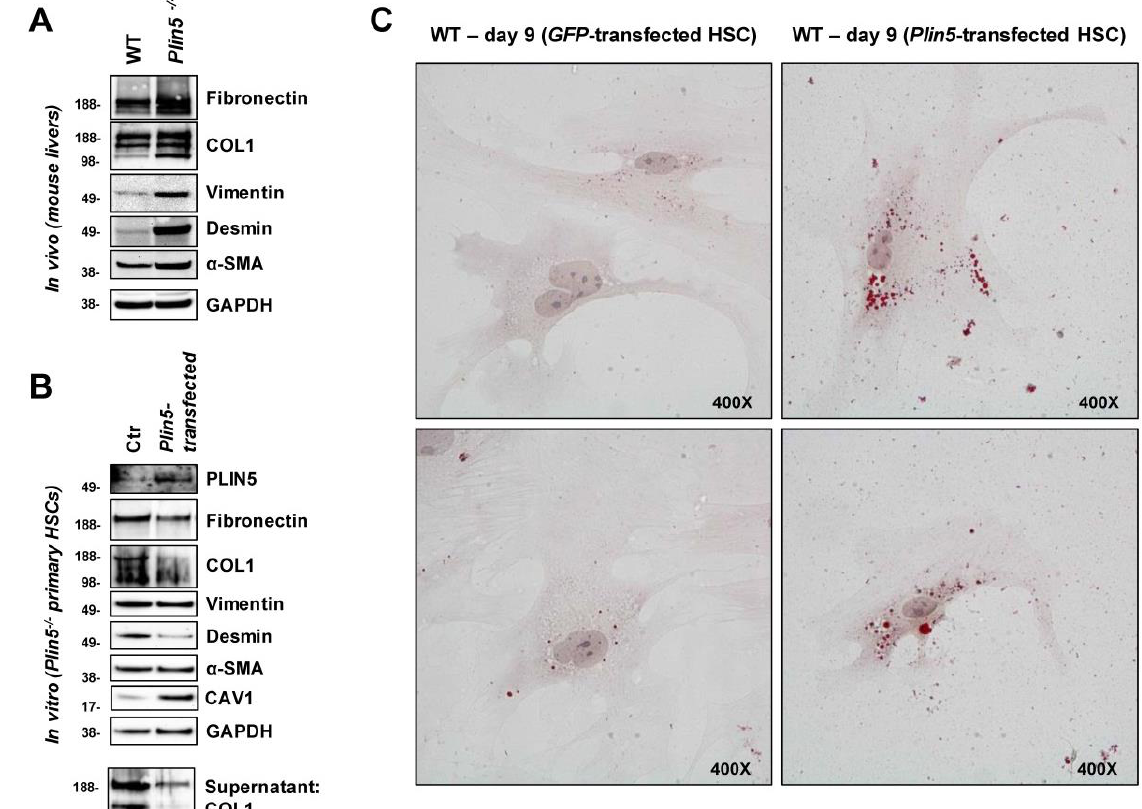
Figure 1. The impact of PLIN5 on hepatic fibrogenesis in mice in vivo and on primary mouse HSC in vitro. ( A ) Western blot analysis of proteins extracted from whole liver of 35 weeks old wild type (WT) and Plin5 − / − mice ( n = 4 – 5 mice per experimental group), while exemplary results from each one mouse are shown. ( B ) Western Blot analysis of cell lysates and supernatants of activated primary HSC from 70 – 78 weeks old Plin5 − / − mice cultured for 9 days and transfected with an expression construct for Plin5 on day 8. ( C ) Oil Red O staining of activated primary HSC from 62 – 69 weeks old WT mice cultured for 9 days and transfected with an expression construct for Plin5 or green fluorescent protein (GFP) constructs on day 8. Microscope images were taken at 400x magnification. Plin5 − / − , Plin5 deficient; Ctr, control.